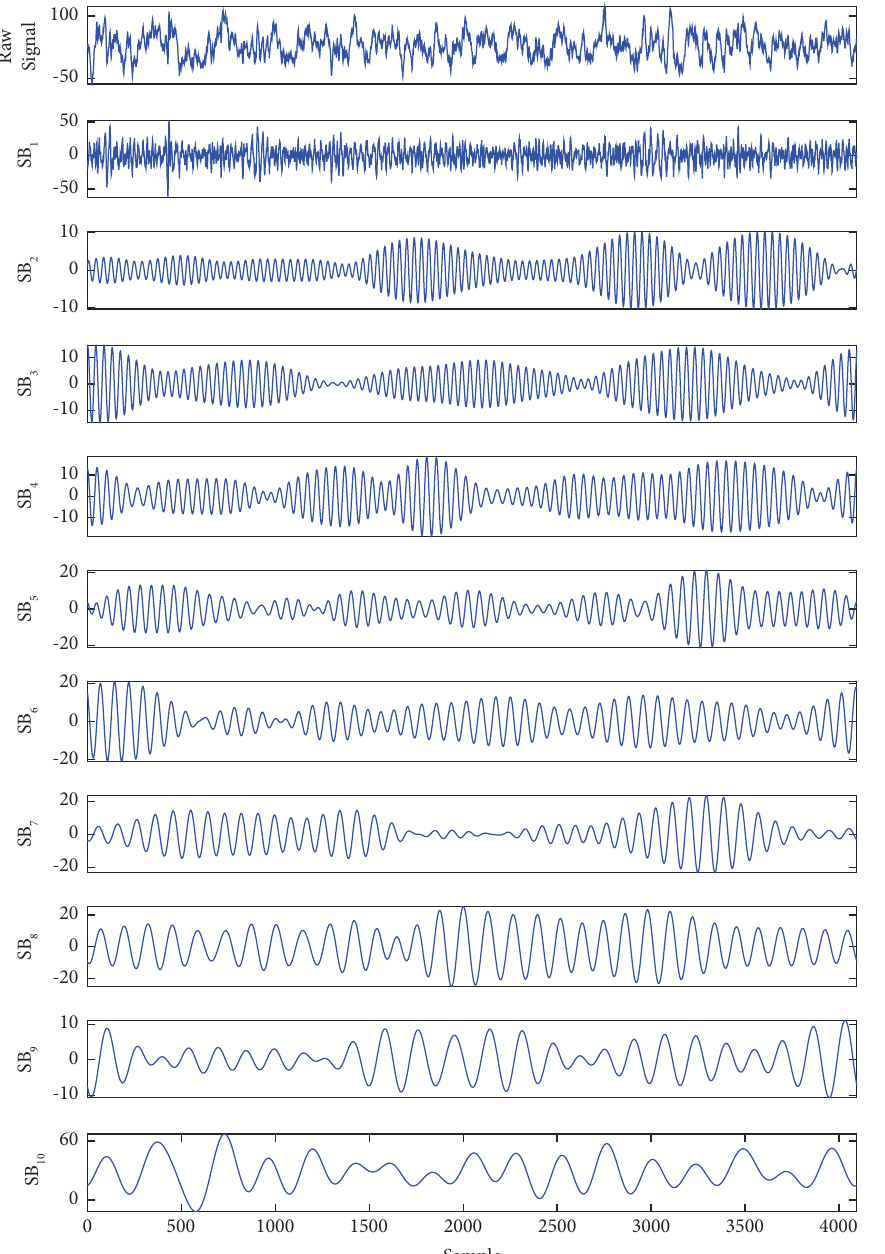
Figure 4: A raw EEG segment from set F in the Bonn dataset and the corresponding sub-bands (SBs) decomposed by complete